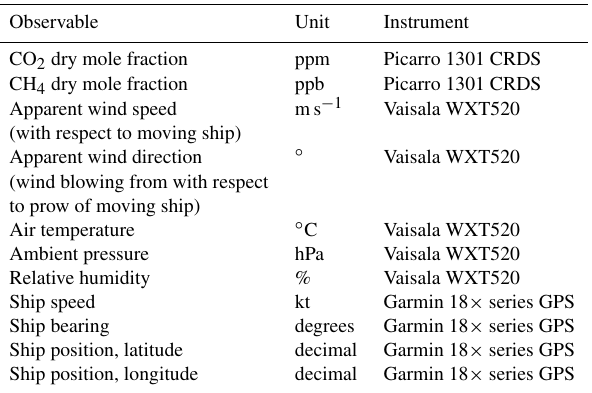
Table 1. List of instruments and observables recorded on board the Rosyth (Scotland, UK; 56 ◦ 1 (cid:48) 21.611 (cid:48)(cid:48) N, 3 ◦ 26 (cid:48) 21.558 (cid:48)(cid:48) W) to Zee- brugge (Belgium; 51 ◦ 21 (cid:48) 16.96 (cid:48)(cid:48) N, 3 ◦ 10 (cid:48) 34.645 (cid:48)(cid:48) E) freight